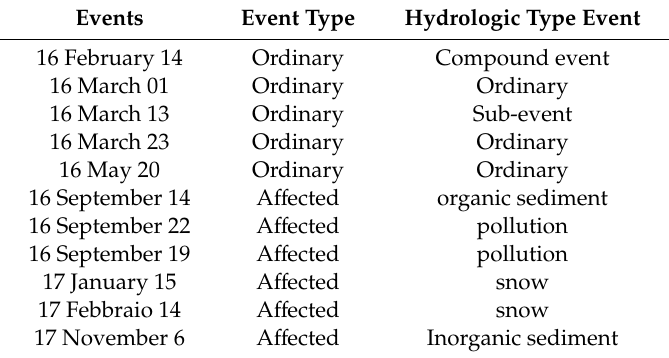
Table 3. Event types